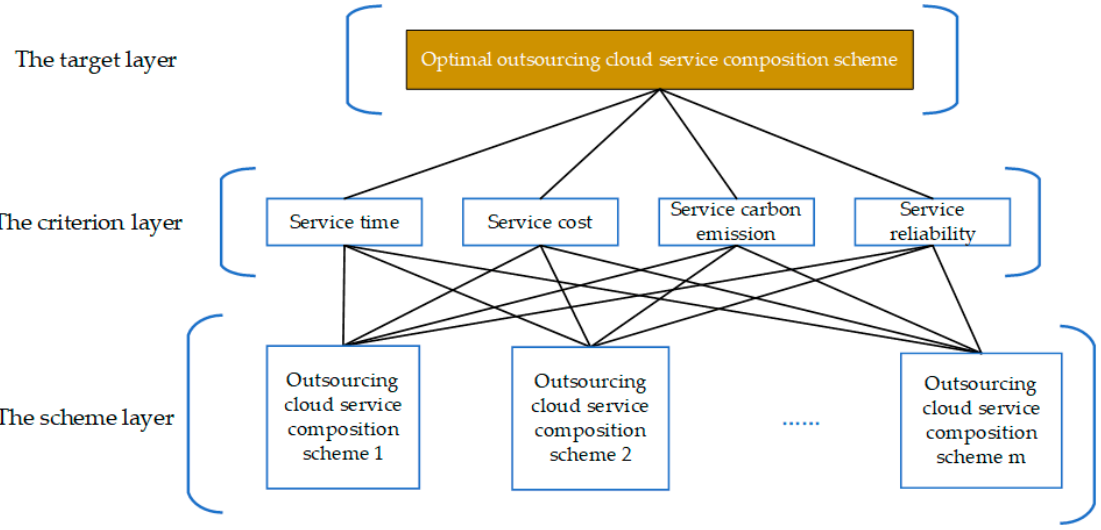
Figure 6. Hierarchical Analysis structure model of SCOS.